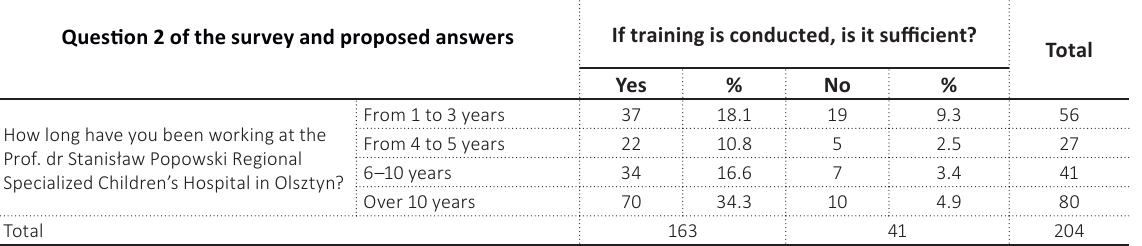
Table 6. Analysis of answers to questions 2 and 7 of the